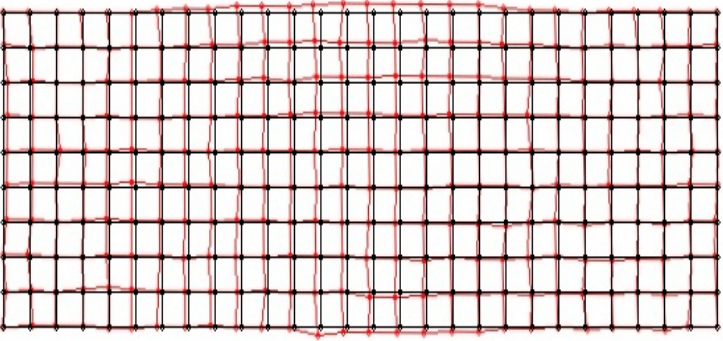
Figure 10. Error compensation results for the object area detected by homography.